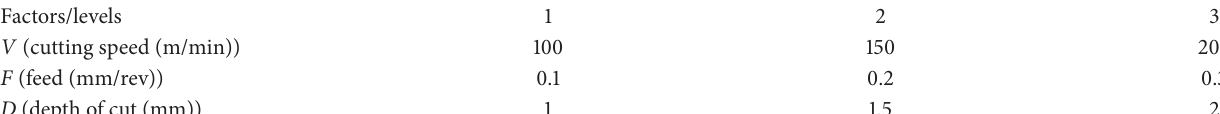
Table 4: Affecting factors and levels selected for turning properties Al6061/12 wt.% Al 2 O 3 /6wt.% MoS 2 .